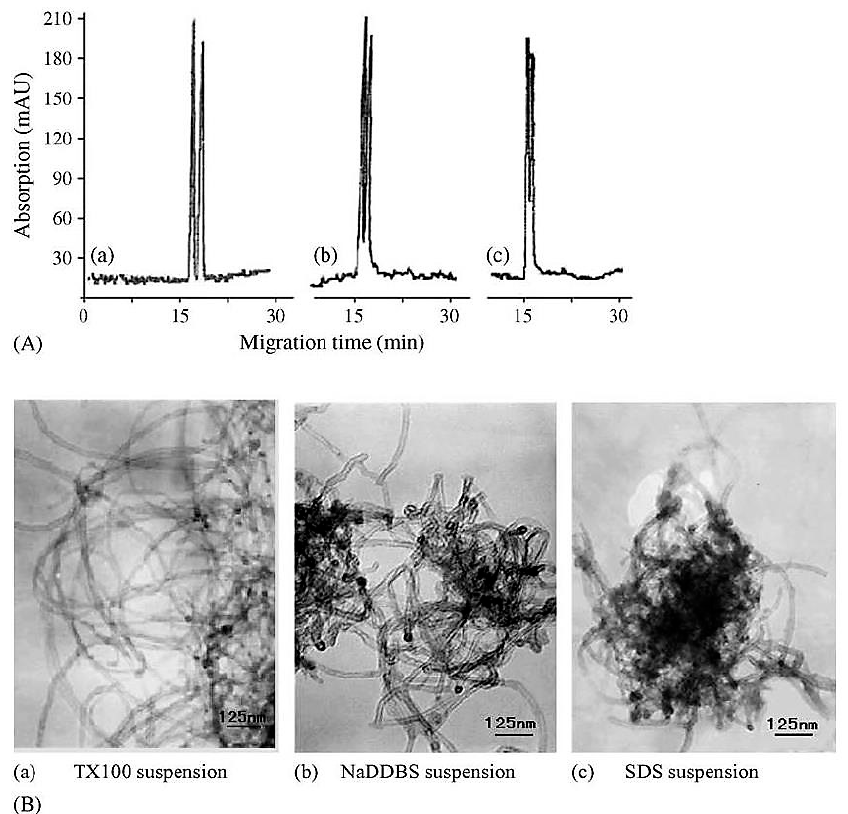
Figure 2. Effect of different kinds of surfactants on the dispersion of CD-MWCNTs and their enantioseparation “Reproduced with permission from N. Na et al. [48]. Copyright Elsevier, 2006”. ( A ) Electropherograms of clenbuterol with CD-MWCNTs dispersed and stabilized in one of the following surfactants; ( B ) Transmission electron microscope (TEM) images of CD-MWCNTs stabilized and dispersed in one of the above mentioned surfactant. ( a ) Trixon X100; ( b ) sodium dodecylbenzene sulfonate and ( c ) sodium dodecyl sulfate.